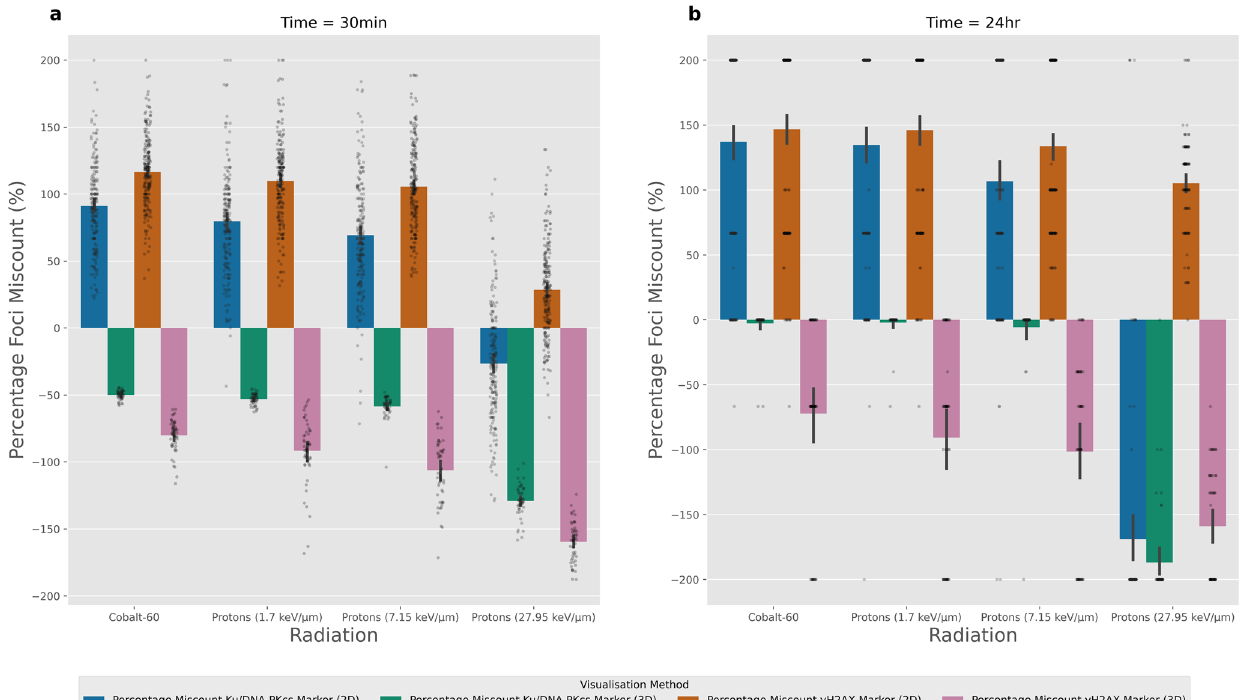
Fig. 7 Percentage foci miscount when using a single slice and 3D stack microscopy. This compares the number of foci detected for the four radiation types delivering 1 Gy at two-time points. Where a and b is 30 min and 24 h post-irradiation respectively. The percentage difference is calculated as the counted (cid:1) simulated ð = ðð counted þ simulated Þ ´ 0 : 5 Þ ´ 100. 3D foci counting consistently under-counts foci at the 30 min time point with its magnitude increasing as a function of LET. Whereas, 3D foci counting appears to correctly count the small number of foci left at 24 h with an exception of consistent under-counting at high LET. Each bar is the averaged result of 50 independent samples and the error bars are the 95% con fi dence intervals. All data are for an emulated Airyscan ×63